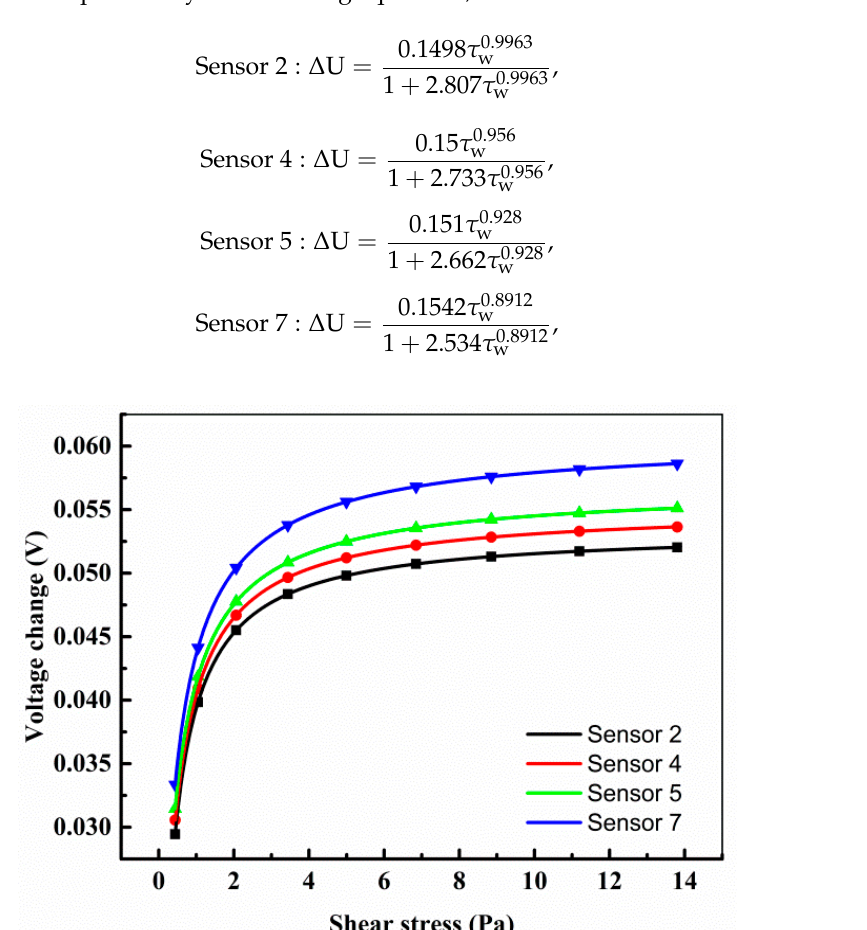
Figure 7. Calibration curves of four sensors.